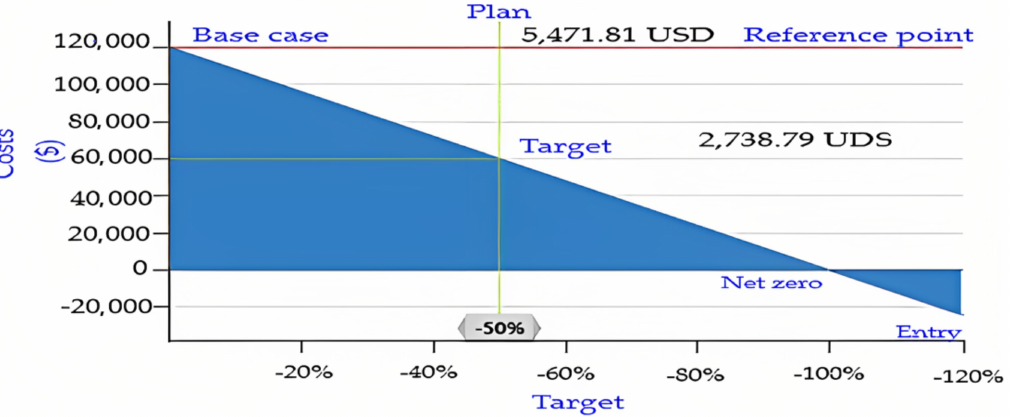
Figure 10. Photovoltaic system design target, 50% reduction in electricity consumption costs, obtained from Retscreen expert